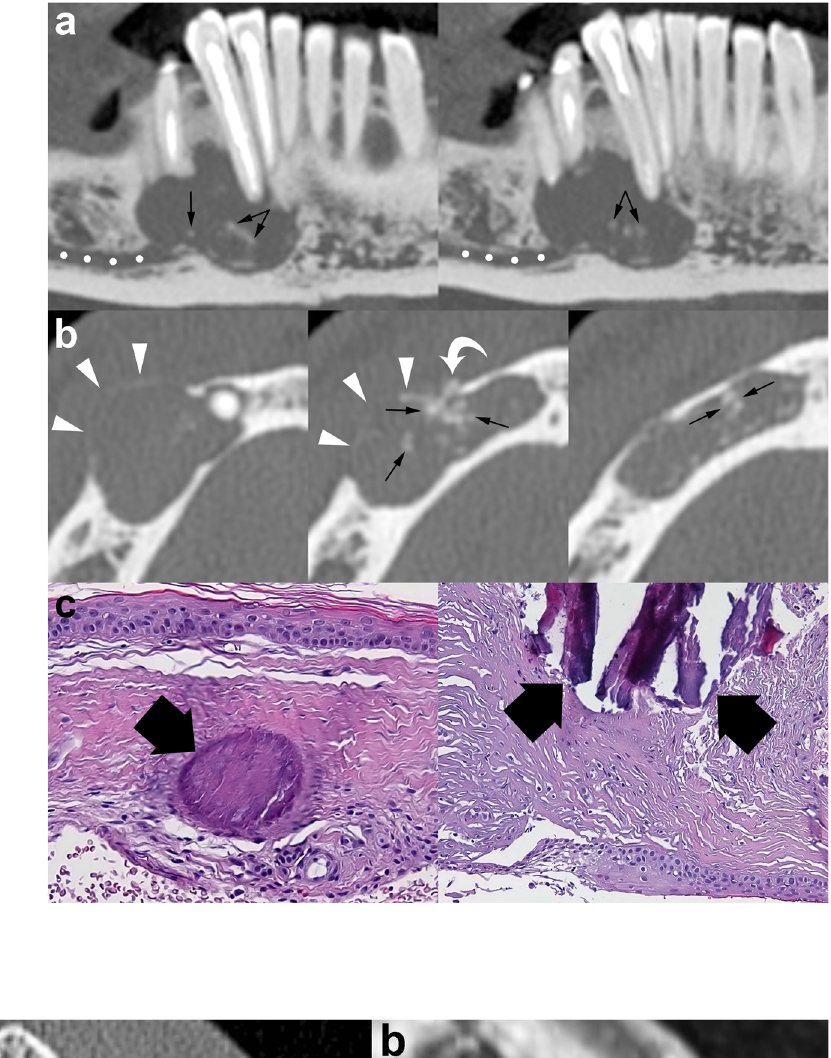
Fig. 14 Unilocular OKC in the left maxillary tuberosity. a Axial MDCT image with bone window demonstrates remodelling and thinning of the adjacent cortices ( arrows ). b Note thin rim enhancement within the lesion on enhanced T1-weighted fat- saturated sequence ( arrowheads